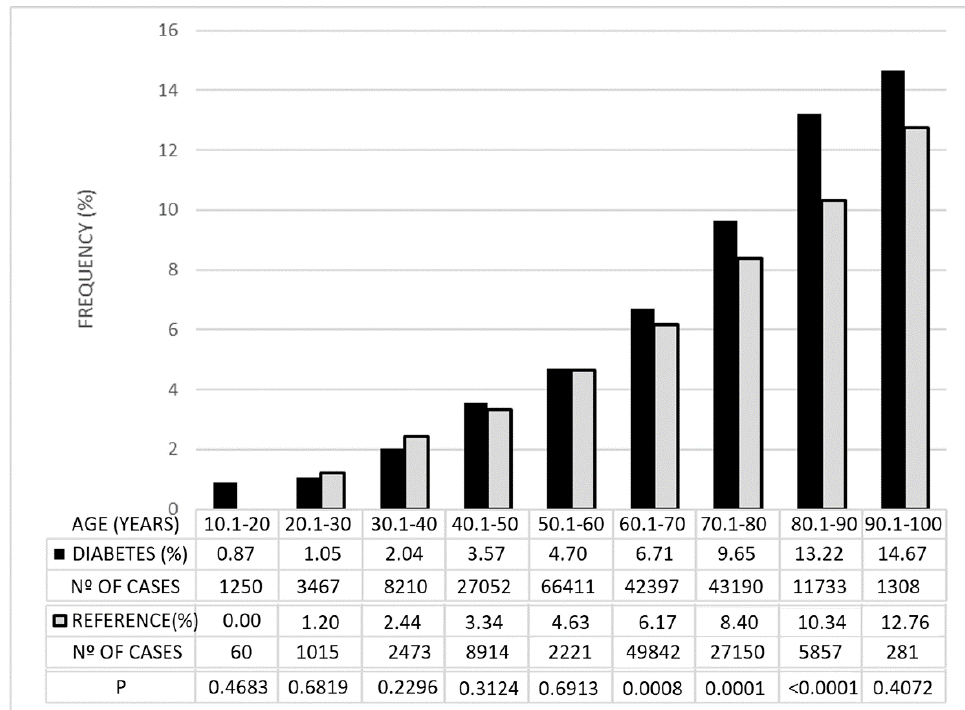
Figure 2. Percentages of cases with GDF < -15 in the diabetic group and in the reference group. They are grouped by age and the degree of statistical significance ( p ) of the differences observed between the two groups.